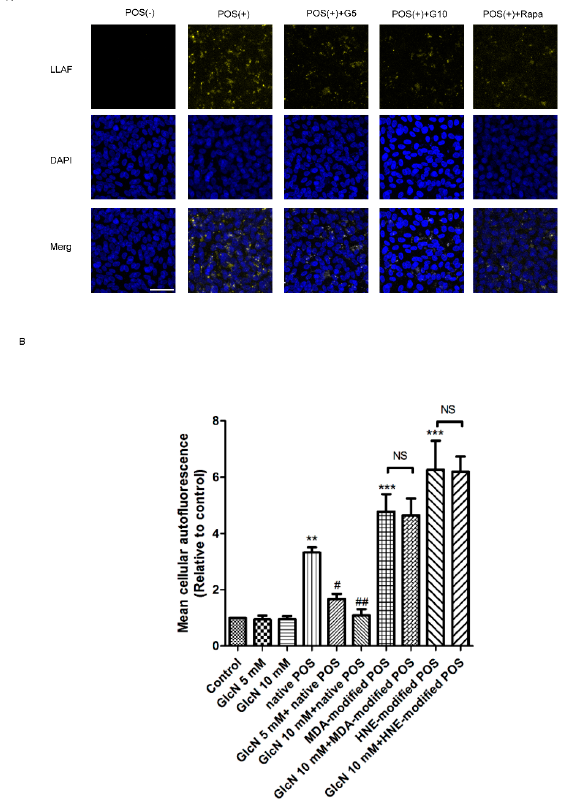
Figure 4. Effects of glucosamine (GlcN) on photoreceptor outer segment (POS)-derived lipofuscin-like autofluorescence (LLAF) in ARPE-19 cells. ( A ) Effect of GlcN on native POS-derived LLAF in ARPE-19 cells. Cells were examined by confocal microscopy following seven days of treatment with native POS, native POS with GlcN (5 or 10 mM), or native POS with rapamycin (Rapa; 300 nM), and were compared with untreated cells. Magnification, ×200. Scale bar: 50 μ M. ( B ) Effect of GlcN on either native or modified POS-derived LLAF in ARPE-19 cells. Cells were treated with GlcN (5 or 10 mM), native POS, native POS + GlcN (5 or 10 mM), MDA-modified POS, HNE-modified POS, MDA- modified POS + GlcN (10 mM), or HNE-modified POS + GlcN (10 mM), and were compared with untreated cells. The mean fluorescence intensity (MFI) was quantified by flow cytometry following seven days of incubation. The results are represented as mean ± SEM. The differences of the MFI in ARPE-19 cells were compared between groups using ANOVA, and Tukey’s test was used for post hoc analysis; ns, not significant; ** p < 0.01 versus the control group; *** p < 0.001 versus the control group; # p < 0.05 versus the native POS group; ## p < 0.01 versus the native POS group.